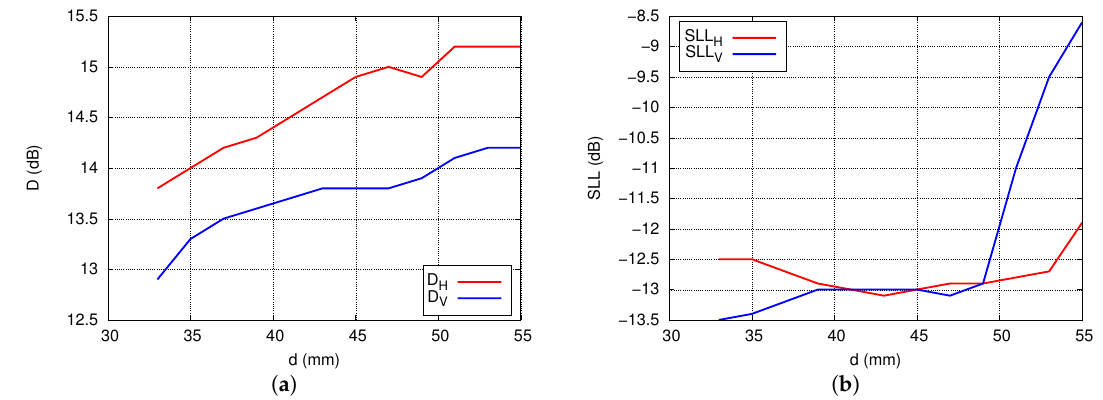
Figure 12. Theoretical values of the far-field parameters of the array versus distance d between the antennas: